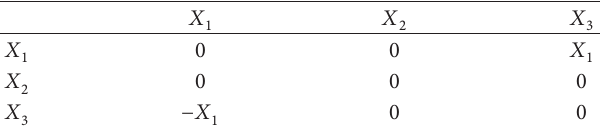
Table 1: Commutator table of the Lie algebra of (2). 𝑋 1